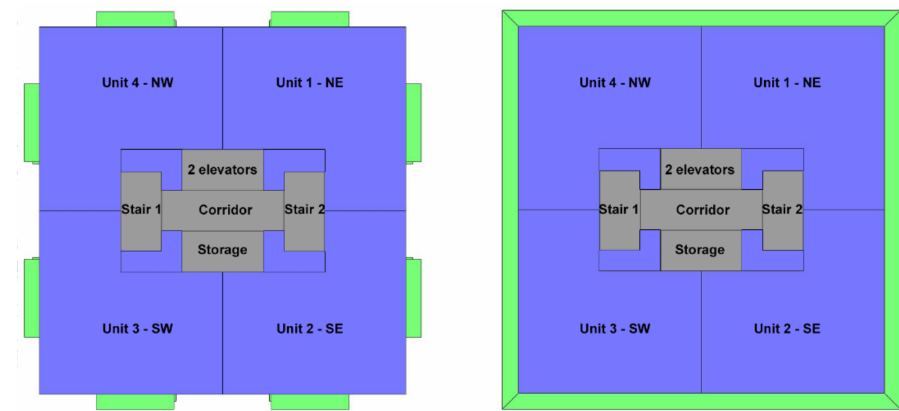
Figure 7. Typical building floor plans with single balconies (left) and continuous balconies (right).